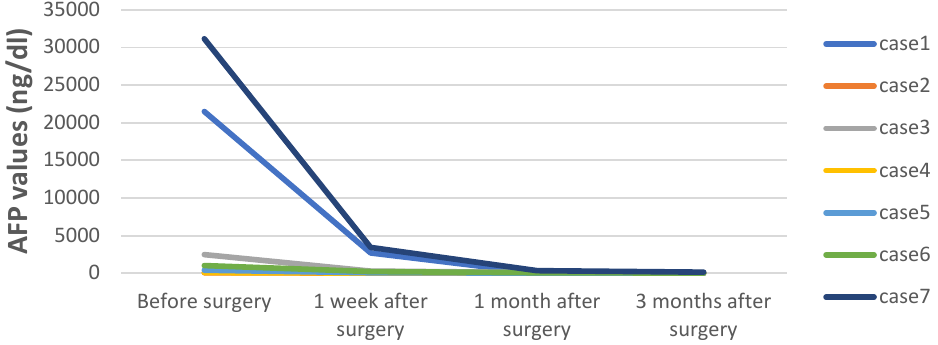
Figure 6. The trend of AFP levels in children with HB undergoing ICG fluorescence-guided laparo- scopic surgery. It can be noted from the chart that AFP levels in all of the children involved decreased significantly after surgery, before finally returning to a normal